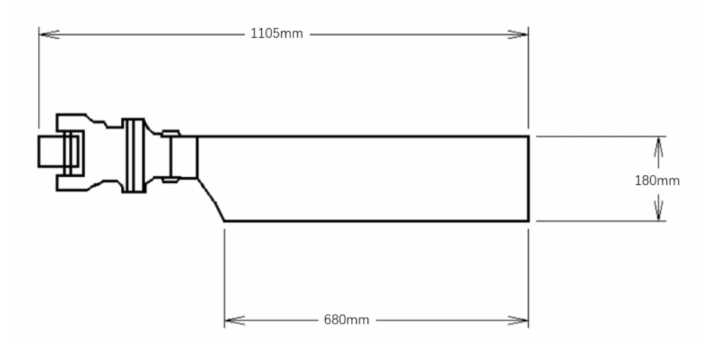
Figure 2. Lynx tail rotor characteristics.